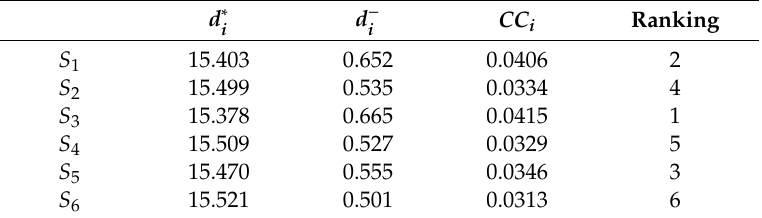
Table 18. The ranking of alternatives for inland